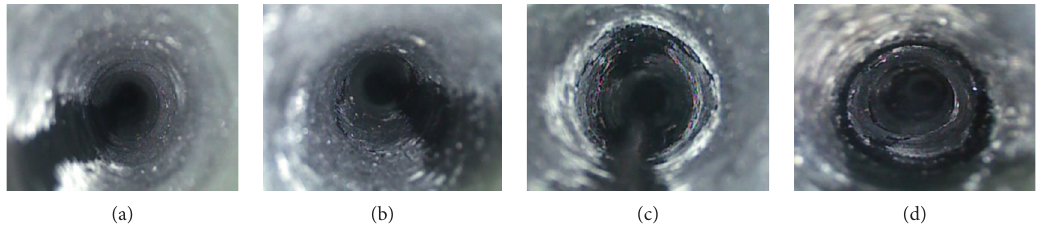
Figure 14: Field monitoring results of fracture distribution in partial deep rock mass: (a) 0.56m; (b) 5.3m; (c) 7.1m; (d) 10.8